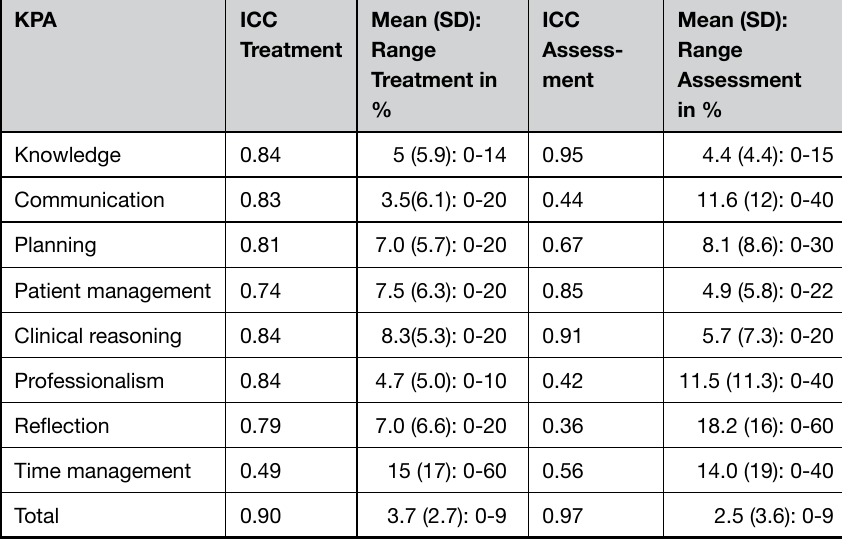
Table 2: inter-rater agreement differences per key performance area